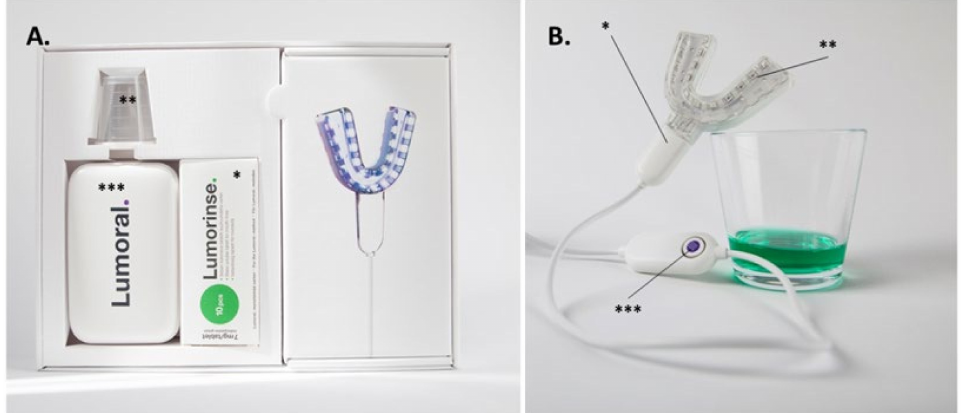
Figure 2. The dual-light aPDT Lumoral ® device. ( A ) The device includes the Lumoral ® light applicator and the effervescent Lumorinse ® tablets (*) to be dissolved in 30 mL of water with a measuring cup (**). A power source (***) for the light applicator. ( B ). The mouthpiece (*) is composed of 48 LED components (**) assembled to provide simultaneous light on both the maxillary and mandibular dental arches. Each LED component emits 405 nm and 810 nm light simultaneously. A push of the control button provides a treatment time of 10 min (***). When dissolved, the ICG in the Lumorinse ® tablet appears